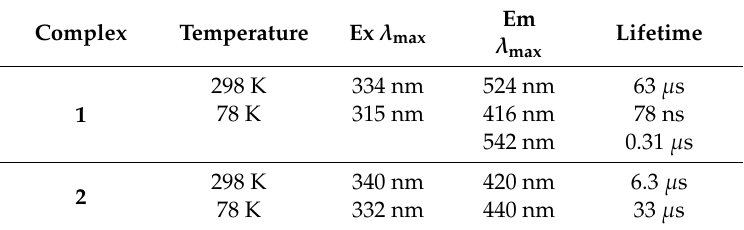
Table 2. Summary of luminescence spectra of 1 and 2 between 78 K and 298